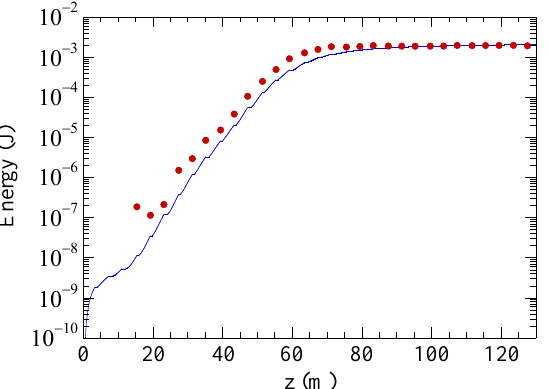
Figure 4. Simulated (blue line) and measured (red circles) optical pulse energy as a function of the propagation distance z for the LCLS experiment. The simulation result is on average over 25 noise